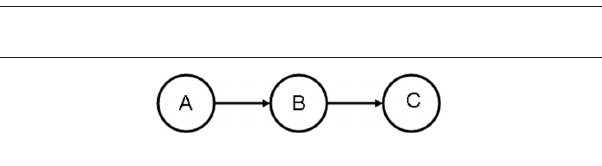
computing job, and each of them can consist of sub-stages such as S2a, S2b, and S2c.